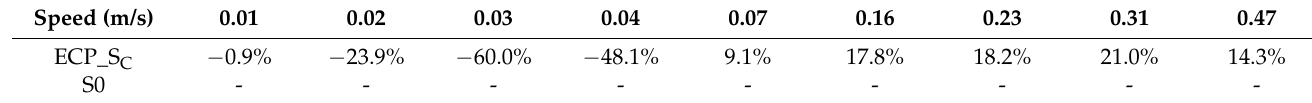
Table 7. Performance of the S0 and ECP_S C specimens (positive values are decreases in friction related to the smooth and uncoated specimen while negative values mean increases in